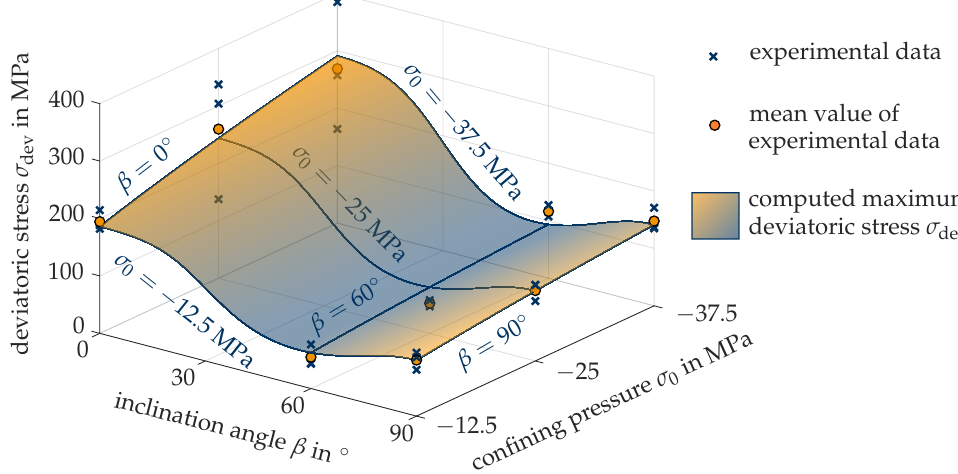
Figure 5. Computed maximum deviatoric stress σ dev in terms of the inclination angle of the foliation planes β and the confining pressure σ 0 together with the experimental data, reprinted with permission from Ref. [51], 2014, by Blümel [2].